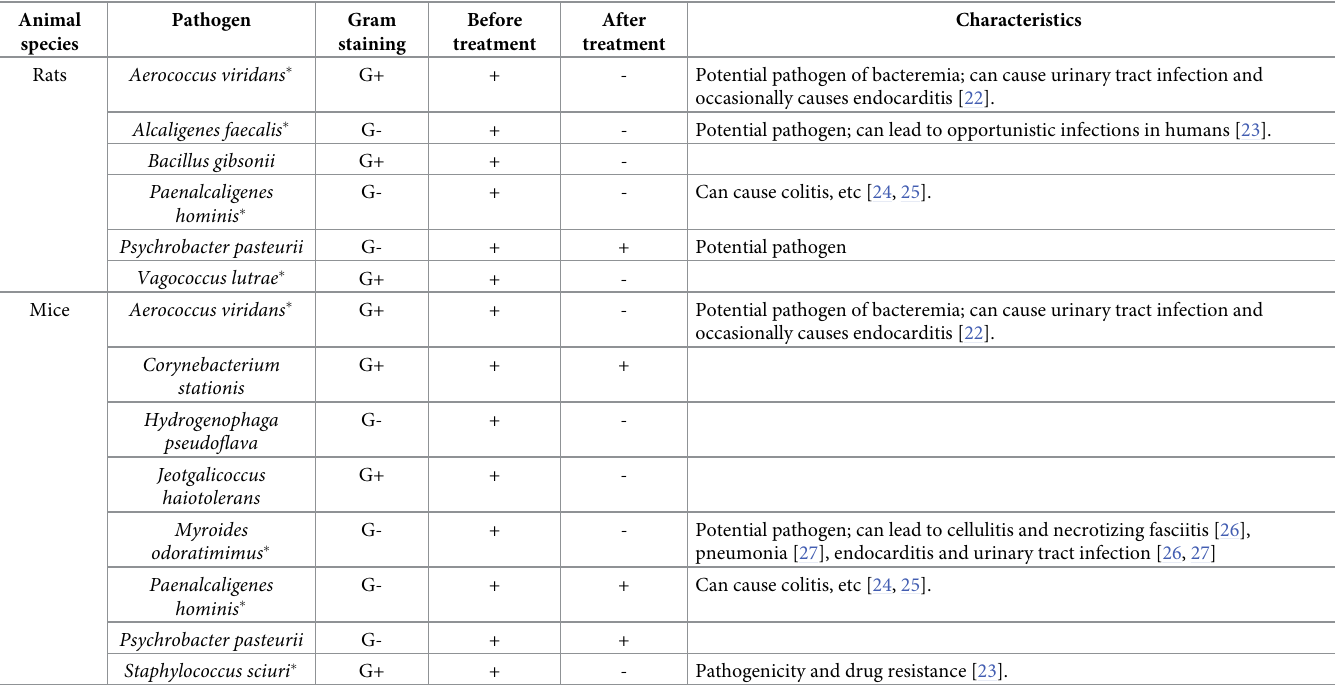
Table 3. The impact of ozone treatment on pathogens in the bedding of rats and